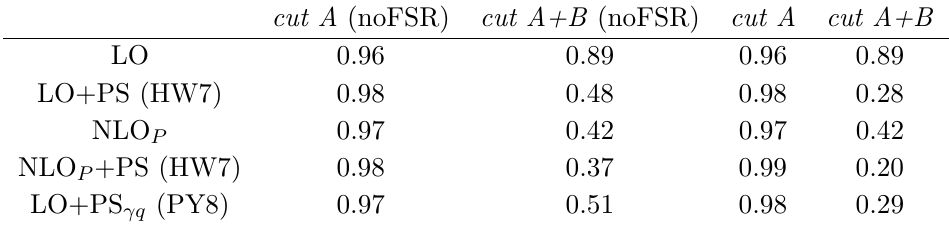
The cut flow analysis. The table shows the acceptance A = σ cut A and cut A+B. See section 3.3 for